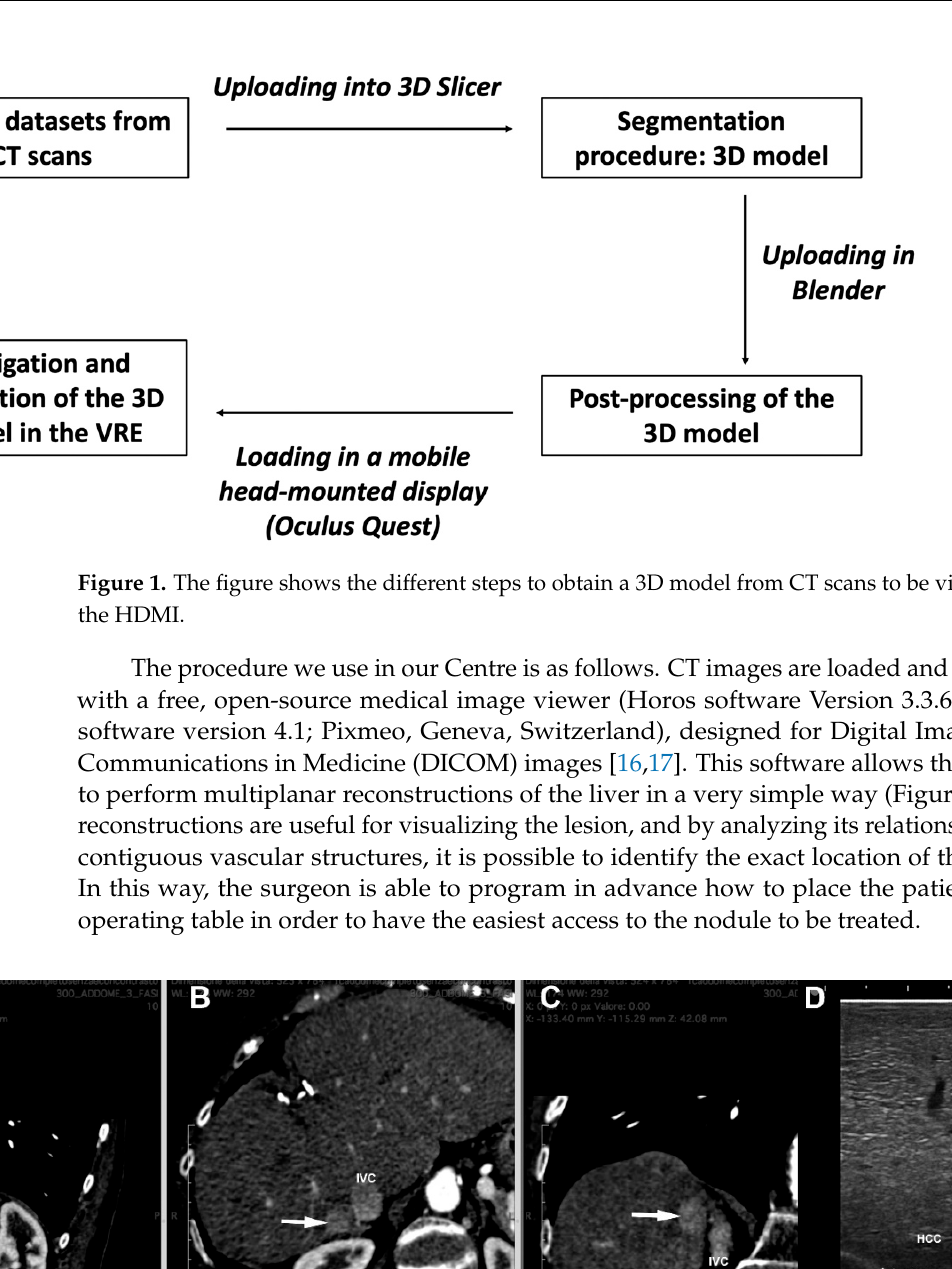
Figure 1. The fi gure shows the di ff erent steps to obtain a 3D model from CT scans to be visualized in the HDMI.